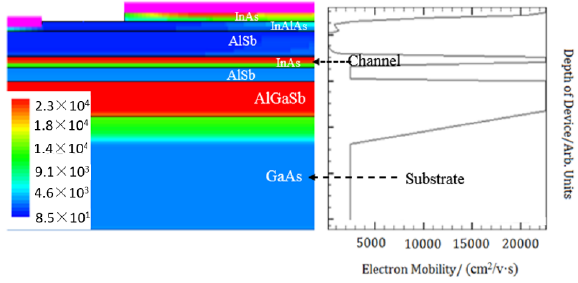
Figure 4. Distribution of electron mobility from simulation.